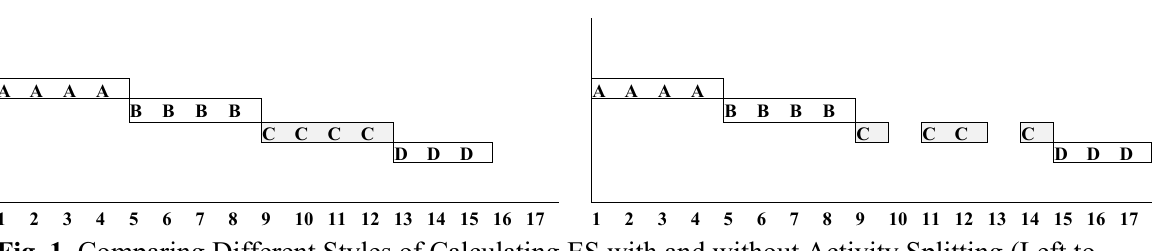
Fig. 1. Comparing Different Styles of Calculating ES with and without Activity Splitting (Left to